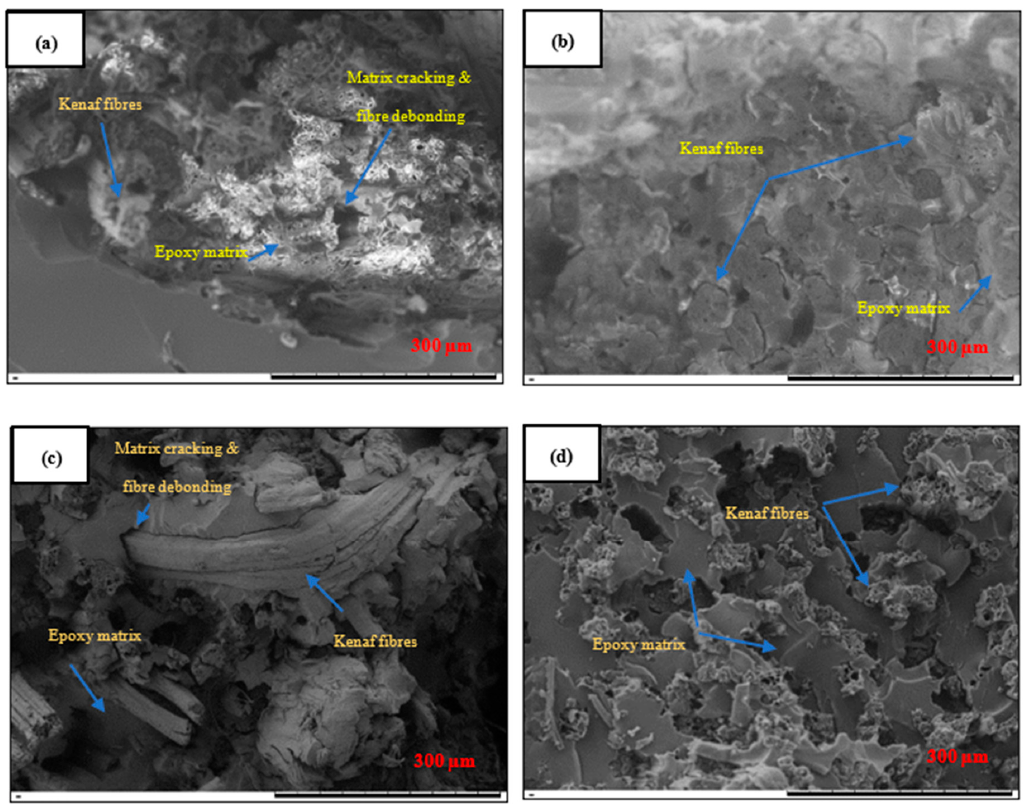
Figure 5. Morphological structures of the fractured surfaces of ( a ) KFRP, ( b ) 5NS-KFRP, ( c ) 13NS-KFRP and ( d ) 25NS-KFRP after they were subjected to the tensile